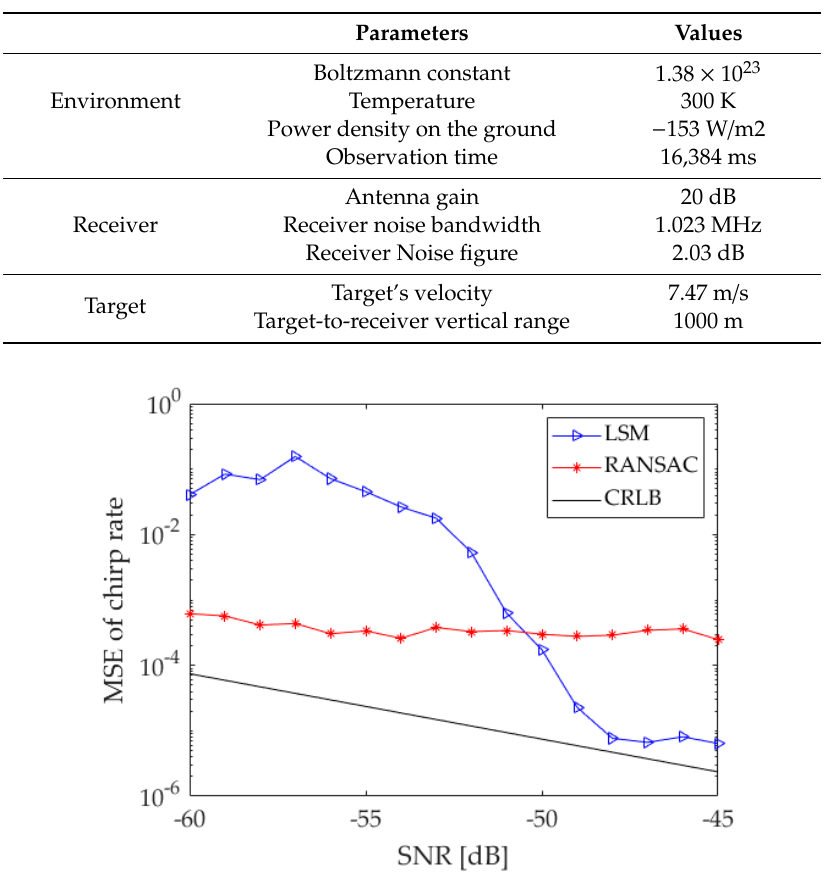
Figure 15. MSEs of chirp rates by using LSM and random sample consensus (RANSAC).